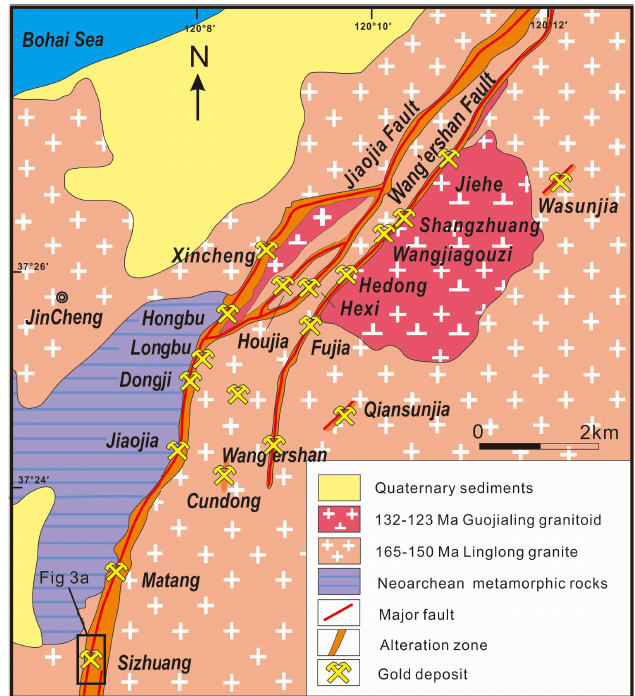
Figure 2. A simplified geological map of the Jiaojia gold belt [17] showing the distribution of major faults and gold deposits: The Sizhuang gold deposit is located at the south segment of the Jiaojia